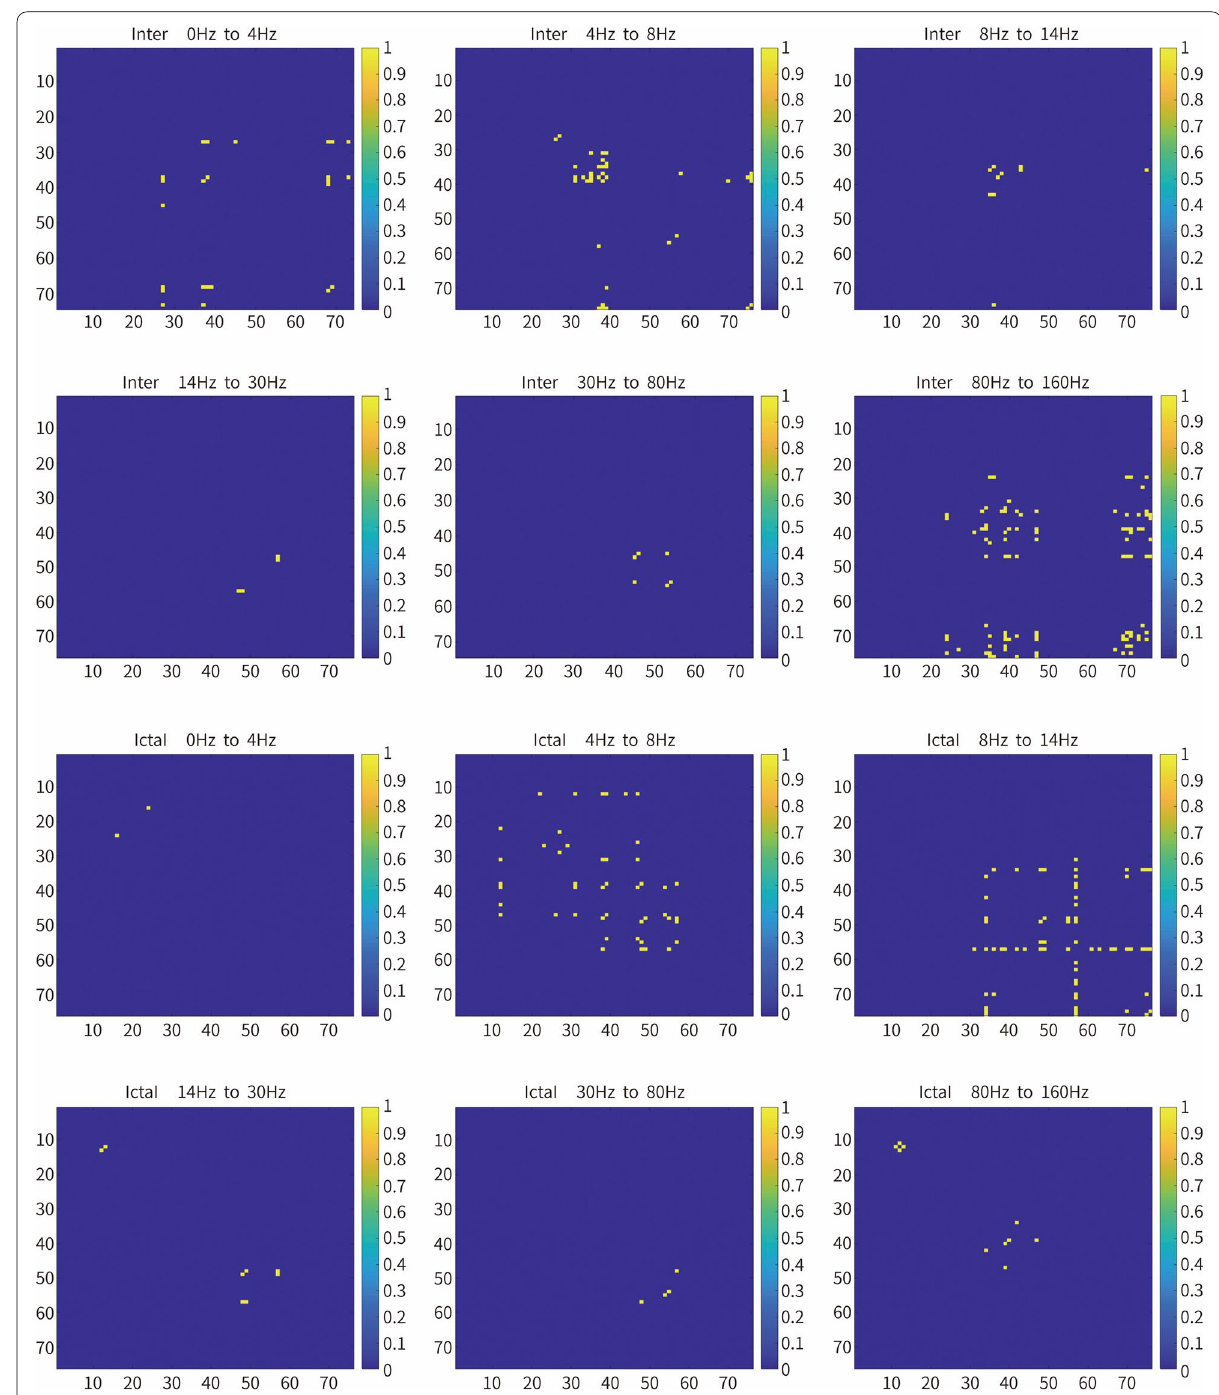
Fig. 5 Enhanced synchronization matrices during the interictal and ictal periods for patient